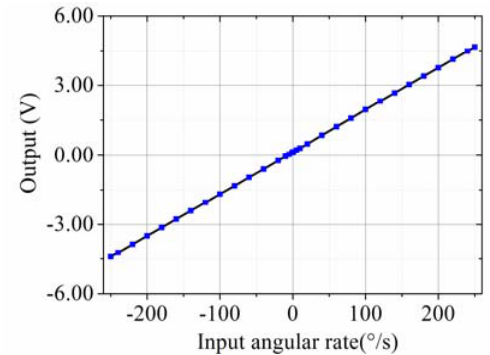
Figure 15. Statistical output with different input angular